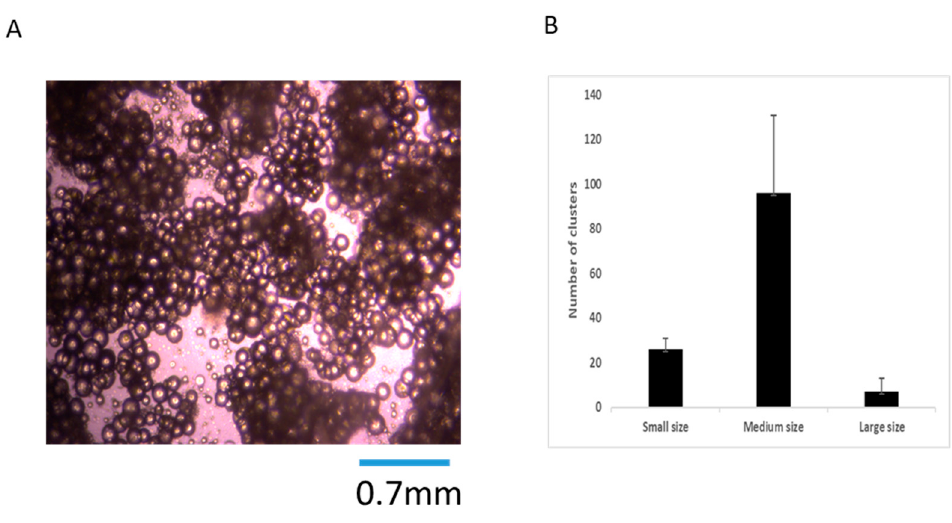
Figure 1. Micro-fragmented adipose tissue (MFAT) indicated most of the clusters were medium sized. ( A ); MFAT image of clusters seen under the microscope ( × 40). ( B ); The number of medium sized clusters (0.3–0.75 mm in diameter) from MFAT of six patients was significantly higher than the smaller sized clusters (<0.3 mm) and large sized clusters (>0.75 mm) ( p < 0.01) in a 10 field measured at ×40 magnification per sample.